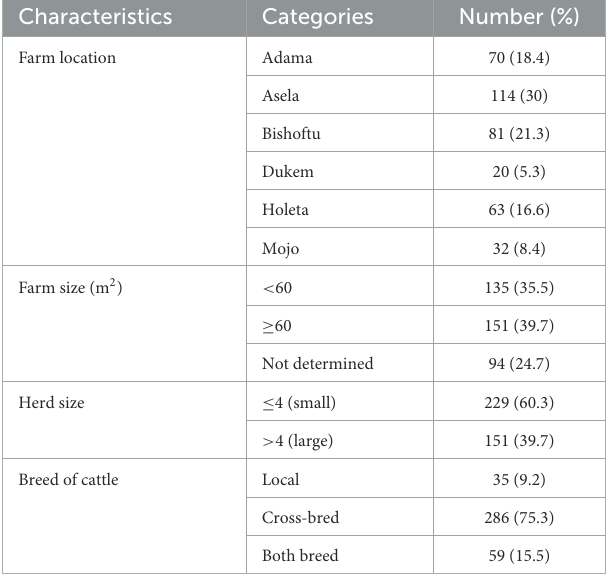
TABLE 2 Characteristics of the study dairy farms in central Ethiopia ( n = 380).